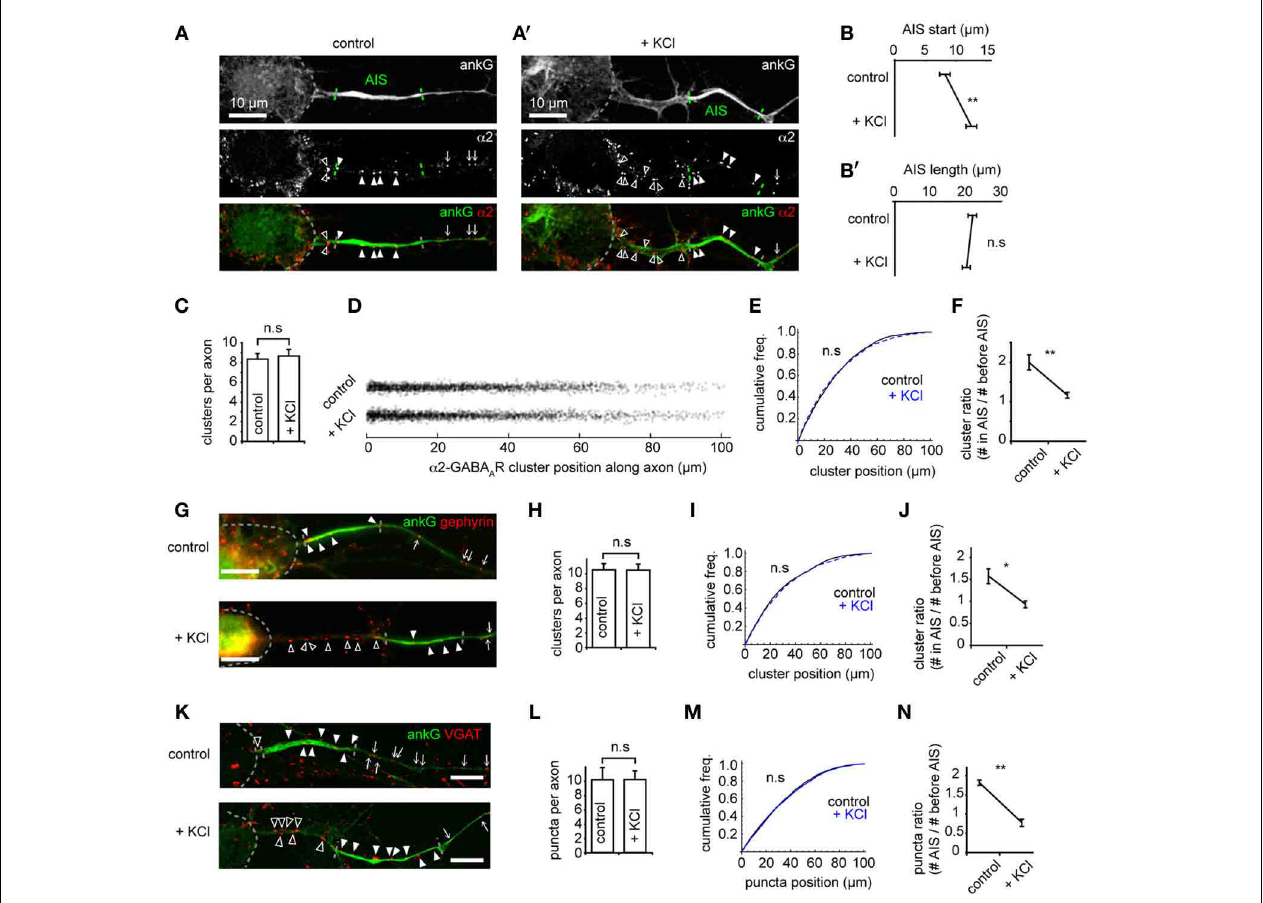
FIGURE 2 | The AIS shifts distally on chronic depolarization, but GABAergic synapse positions are not affected. (A) As Figure 1A . Neuron stained for ankG and GABA A R- α 2 subunit. Soma, AIS and GABA A R cluster positions along the axon are indicated (open arrowhead: cluster before AIS; closed arrowhead: cluster within AIS; arrow: cluster beyond AIS). AIS endpoints are determined from ankG intensity. (A (cid:2) ) as ( A) , for a KCl-treated neuron. (B) AIS start position is greater after KCl treatment ( p = 0 . 007, n = 10 experiments); (B (cid:2) ) AIS length is not affected ( p > 0 . 05). (C) Number of GABA A R clusters per axon is unchanged ( p > 0 . 05). (D) Positions of all GABA A R clusters from control and KCl pools. (E) GABA A R cluster position along axons (control, black, n = 1944 clusters; KCl, blue, dashed, n = 2130 clusters, p > 0 . 05, Mann-Whitney U -test). (F) Cluster ratio (in AIS / before AIS) is lower in KCl-treated neurons, p = 0 . 004, n = 5 experiments. (G) Example neurons stained for ankG and gephyrin (labeled as in A ). Top: control, bottom: KCl. Scale bar = 10 μ m. (H) Total number of gephyrin clusters per axon is not significantly different ( p > 0 . 05, n = 5). (I) Cumulative frequency plot of gephyrin cluster position along axons (control, black, n = 1585 clusters; KCl, blue, dashed, n = 1686 clusters). Distributions not